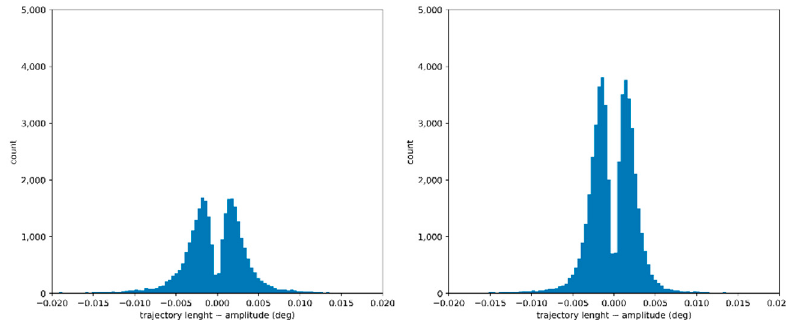
Figure A17. Histogram of the amplitude segments for the painting 6 dataset.